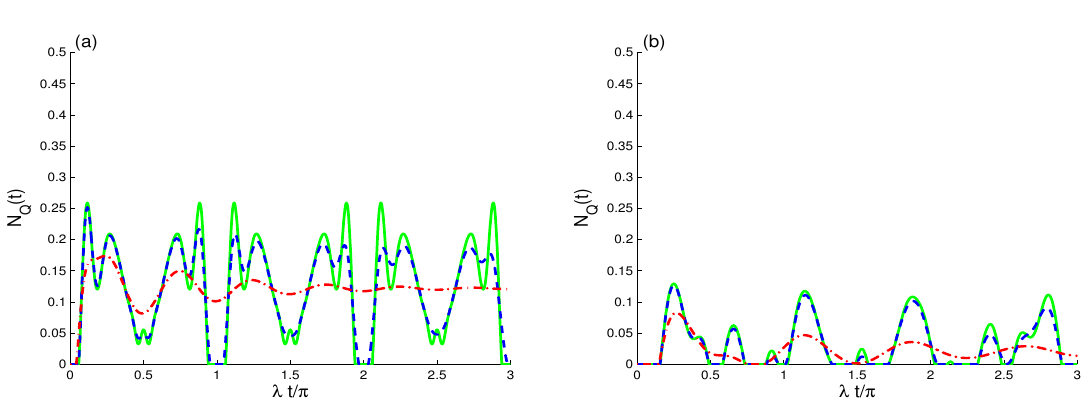
,1 ) in ( b ) with different 4